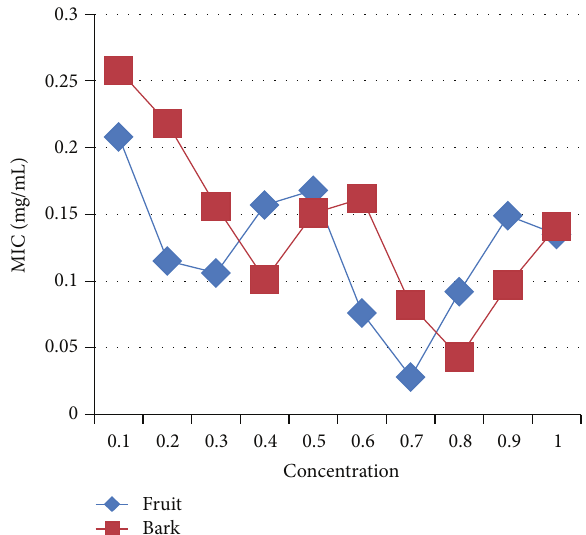
Figure 8: Zone of inhibition produced by different parts of C. ambrosioides against A. niger .